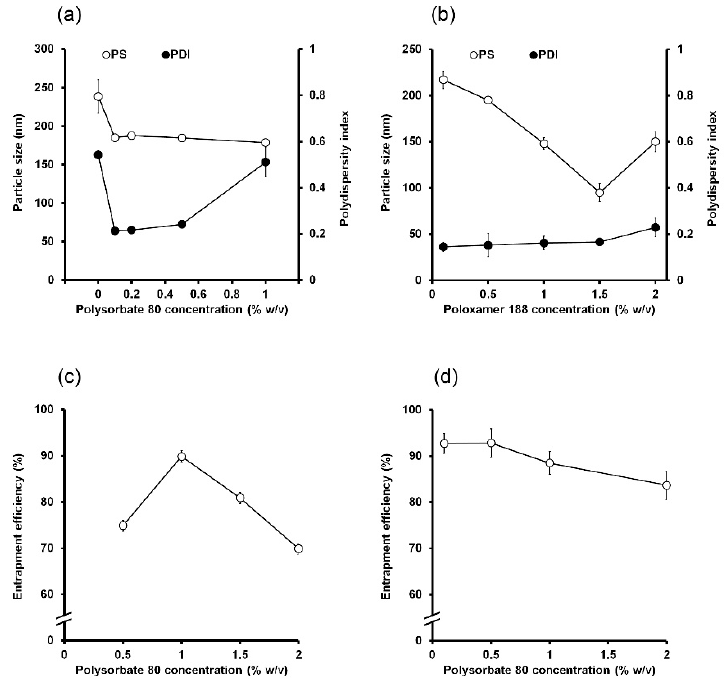
Figure 4. E ff ects of emulsifier on SLNs and NLCs. ( a ) E ff ects of polysorbate 80 concentration on PSs Figure 4. Effects of emulsifier on SLNs and NLCs. ( a ) Effects of polysorbate 80 concentration on PSs and PDIs of NLCs, data obtained from [76]. ( b ) E ff ects of poloxamer 188 concentration on PSs and and PDIs of NLCs, data obtained from [76]. ( b ) Effects of poloxamer 188 concentration on PSs and PDIs of SLNs, data obtained from [165]. ( c , d ) E ff ects of polysorbate 80 concentration on EEs of SLNs, PDIs of SLNs, data obtained from [165]. ( c , d ) Effects of polysorbate 80 concentration on EEs of SLNs, data obtained from [161] (for ( c )) and [160] (for ( d data obtained from [161] (for ( c )) and [160] (for ( d )).